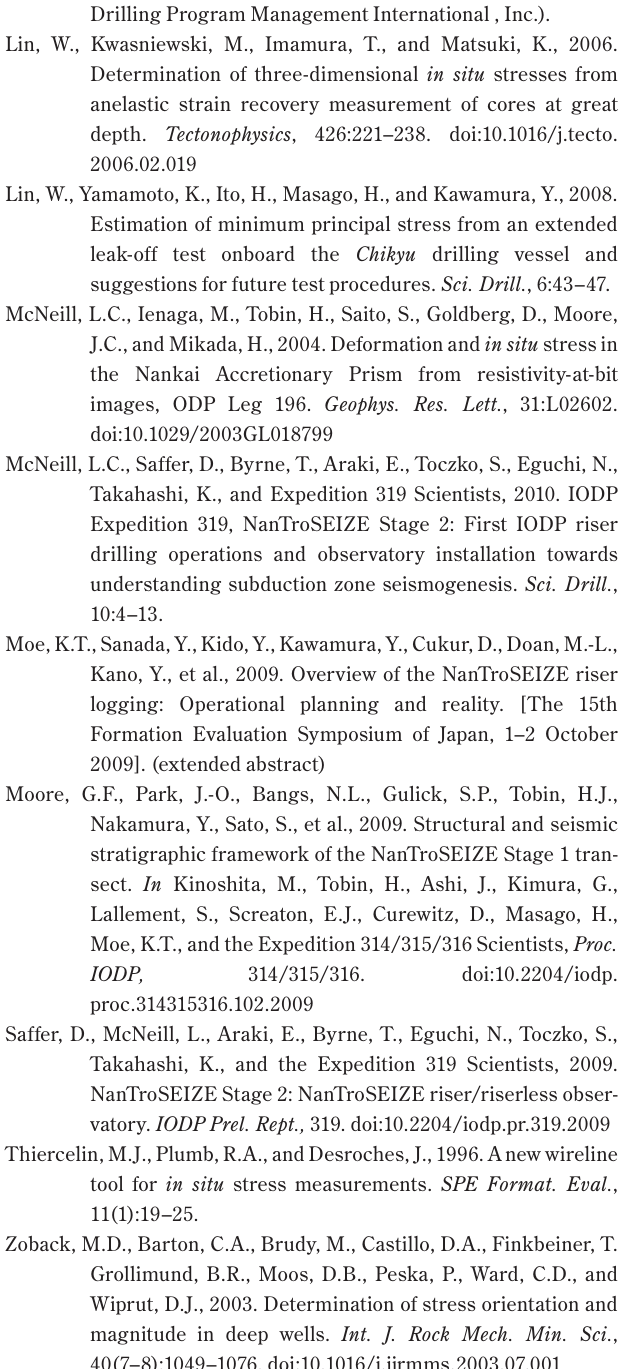
Fig. 1: Photo courtesy of T. Ito, Tohoku